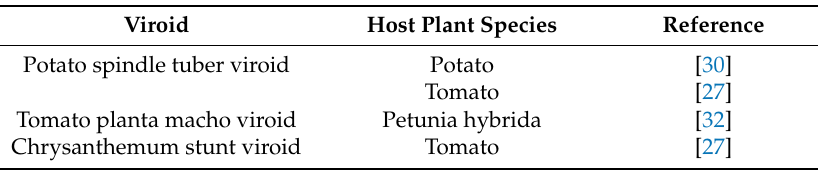
Table 2. Horizontal transmission of